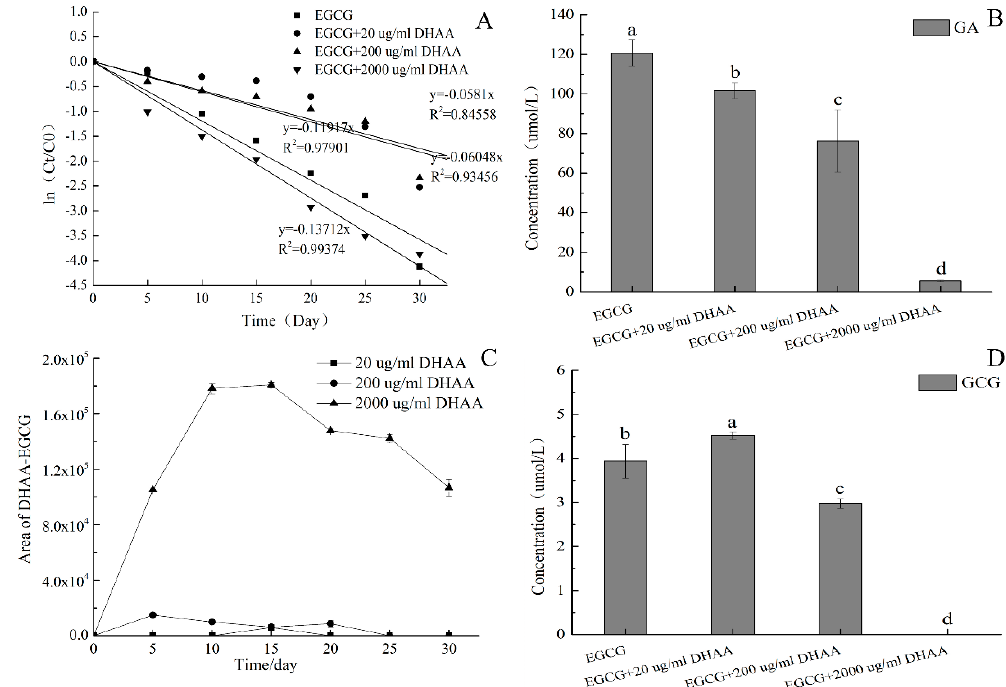
Figure 2. The effect of different dehydroascorbic acid (DHAA) amounts on the EGCG stability: ( A ) Apparent first-order kinetics of EGCG degradation of four incubation systems; ( B ) effect of DHAA on the concentration of GA at the end of reaction ( p < 0.05); ( C ) changes of DHAA–EGCG area during storage; ( D ) effect of DHAA on the concentration of gallocatechin gallate (GCG) at the end of reaction. Date represent means ± SD of three replicate samples. Different letters indicate significant differences according to Duncan’s multiple range test ( p < 0.05).